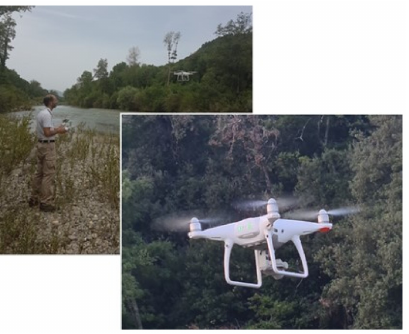
Figure 3. DJI Phantom 4 Pro used during UAV flight